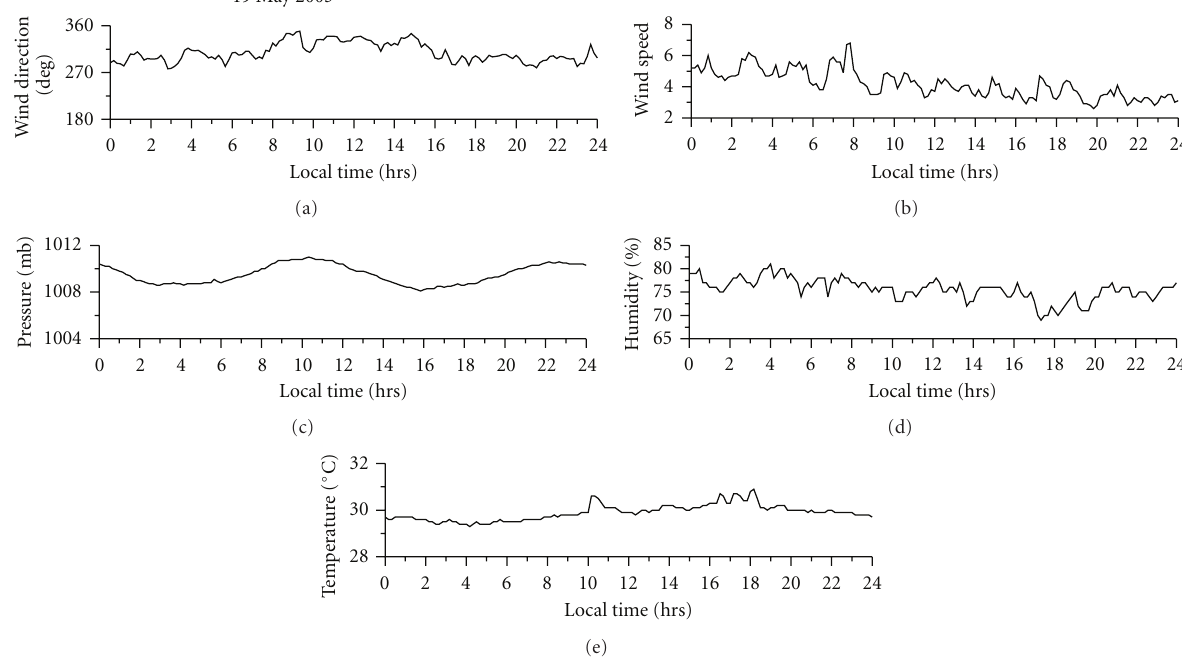
Figure 6: Diurnal variation of meteorological parameters on May 19,